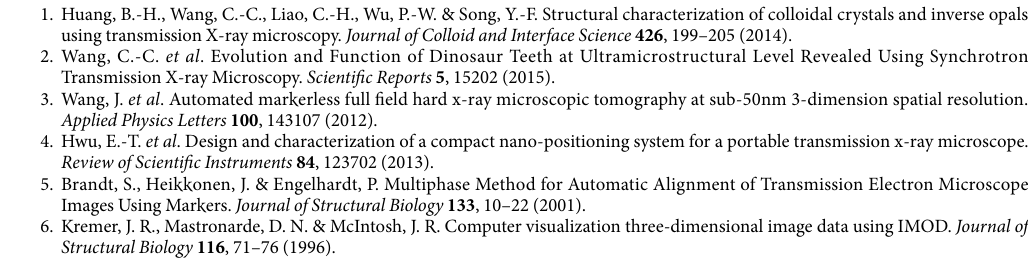
different iteration times after Faproma second correction process. The reconstruction quality was evaluated using three-dimensional Fourier shell correlation (FSC) method 28, 29 (see Fig. 8b). According to a 0.5 cutoff, for different FSC curves with various iterations, optimization was reached after only 2 iterations, and the curve extended to high spatial frequency. The Faproma algorithm is simply coded based on Matlab (Matlab R2014b, The MathWorks, Inc.) in this work for a quick demonstration. Yet, the algorithm speed may still be increased by algorithm optimization, or through using a graphics processing unit (GPU) to run the calculation. The most important advantage of the Faproma registration algorithm is that it dramatically reduces the hardware requirements for both data processing and tomography acquisition, alleviating the need for ultrahigh stable motion components in tomographic systems.